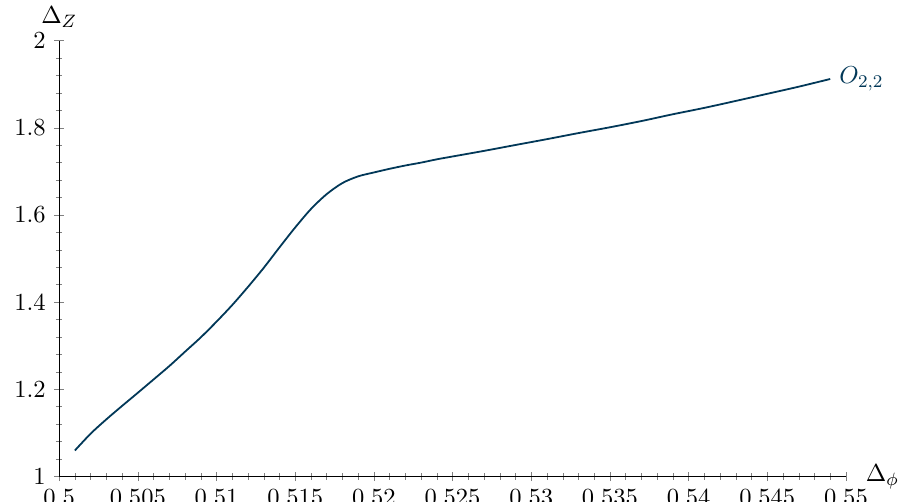
Figure 14: Upper bound on the dimension of the first scalar Z operator in the φ × φ OPE as a function of the dimension of φ . The area above the curve is ar bs excluded.